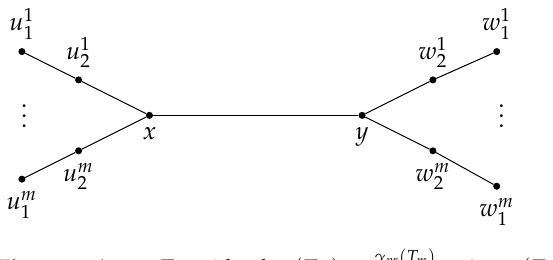
Figure 2. A tree T m with sd γ